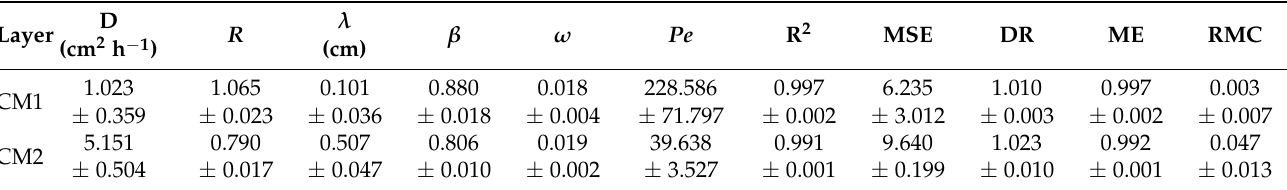
Table 6. Estimated parameters, determination coefficient R 2 , and statistical criteria for the two-region model for CM1 and CM2 for the tracer